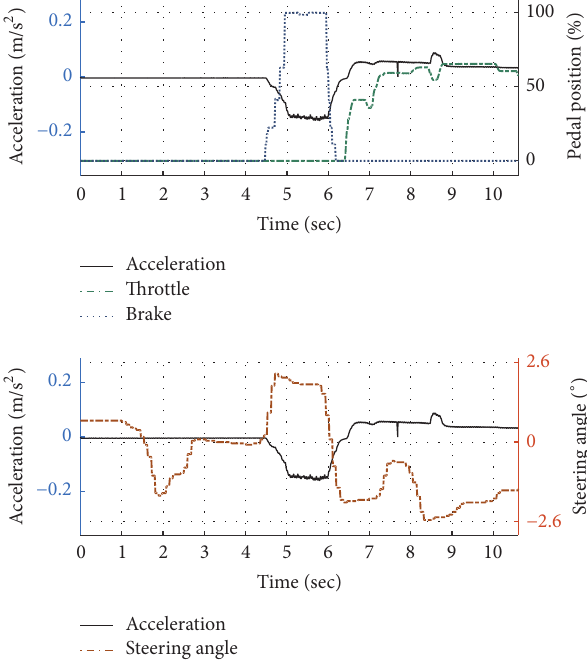
Figure 4: Veh S signals recorded in a BRK